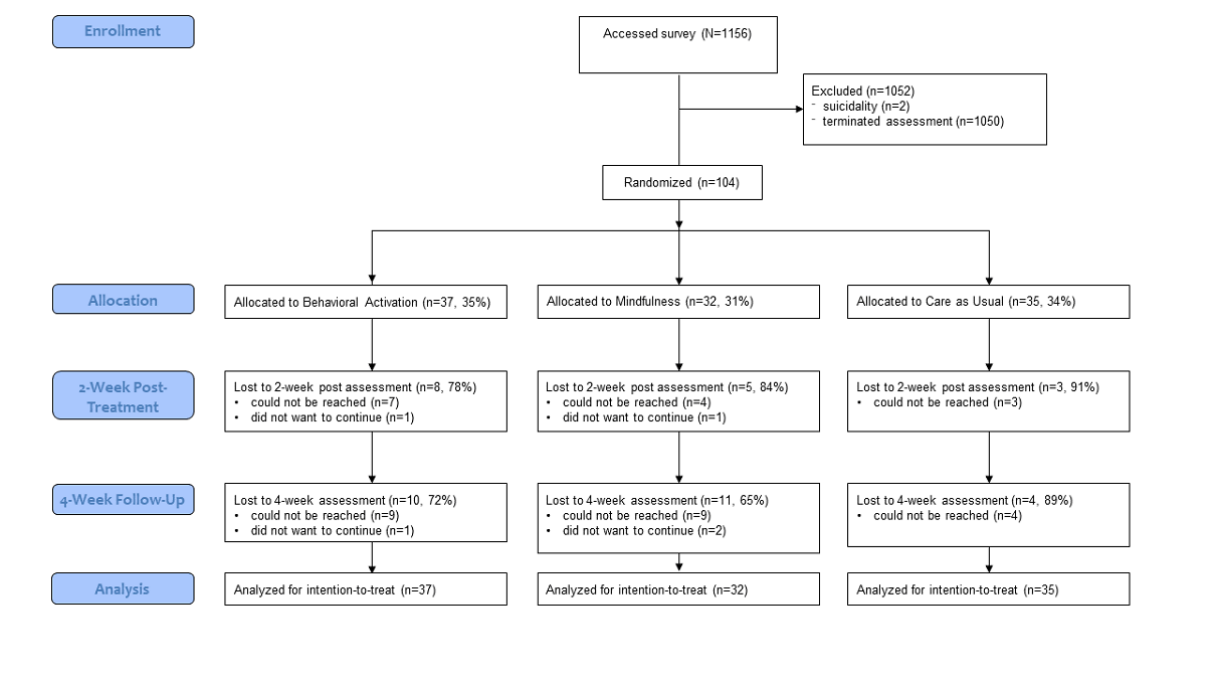
Figure 1. Flowchart of participation in the